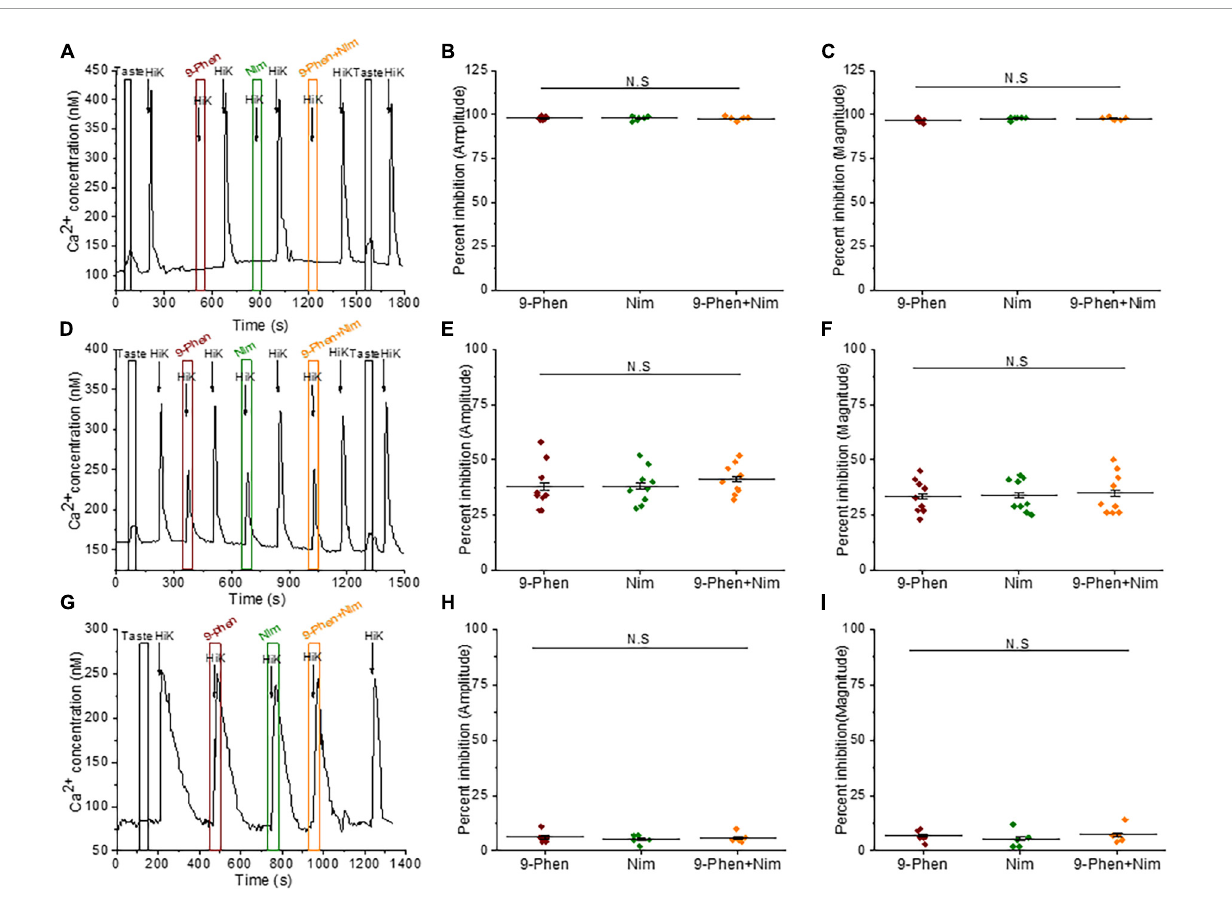
FIGURE4 TRPM4 regulates L-type VGCC activity in BR cells. (A–C) In some BR cells, the calcium signals due to 50 mM KCl were abolished by both 9-phenanthrol (50 µ M) and nimodipine (10 µ M) (amplitude; F ( 2 , 15 ) = 0.32, p = 0.73) (magnitude; F ( 2 , 15 ) = 2.14, p = 0.15, n = 6 cells from 3 mice). (D) In other BR cells, calcium influx was partially reduced when either TRPM4 or L-type VGCCs were individually inhibited as well as when they were co-inhibited. (E) The percent inhibition of the peak amplitudes ( F ( 2 , 24 ) = 0.36, p = 0.70) and (F) magnitudes ( F ( 2 , 24 ) = 0.06, p = 0.94) of the calcium responses were comparable when either 9-phenanthrol, nimodipine or 9-phenanthrol + nimodipine were applied ( n = 9 cells from 5 mice). In non-BR Type III cells, inhibiting TRPM4 or L-type VGCC activity did not affect the calcium signals due to 50 mM KCl. (G) A representative trace is shown. Neither the peak amplitudes ( H , F ( 2 , 12 ) = 0.23, p = 0.79) or peak magnitudes ( I, F ( 2 , 12 ) = 0.40, p = 0.68) of the calcium signals were affected by either inhibitor ( n = 5 cells from 3 mice) (N.S = Not